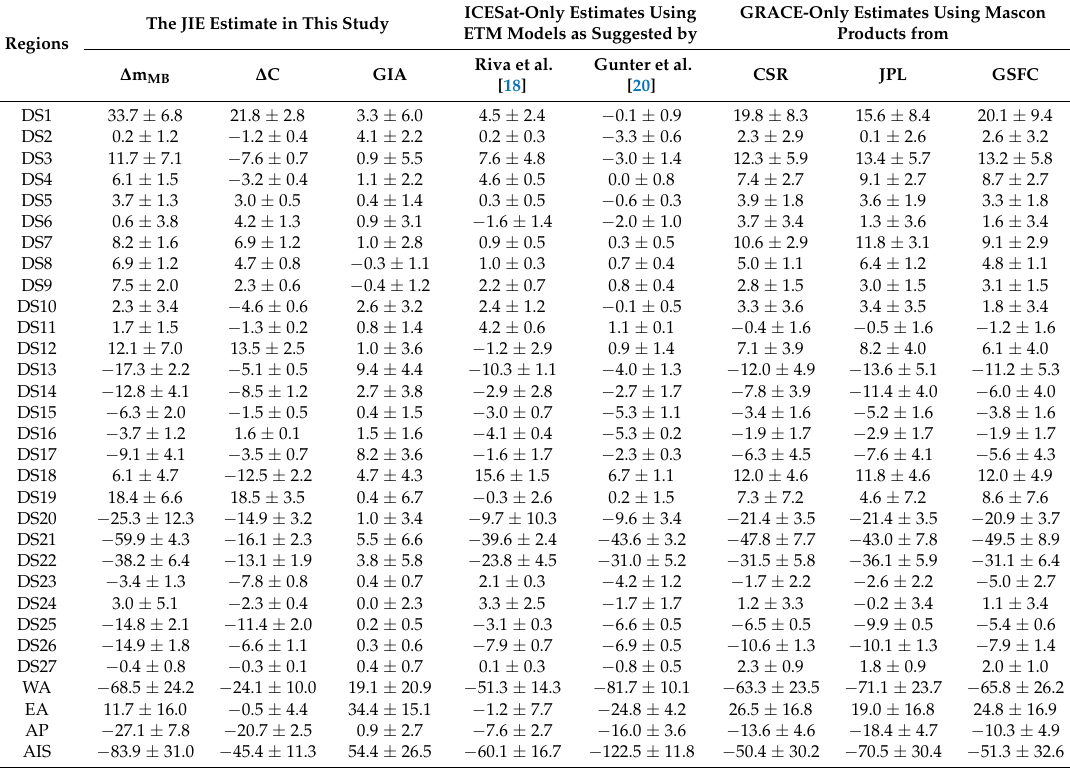
Table 5. The mean trends of 27 Antarctic drainage systems, the AP, WA, East Antarctica (EA), and the entire AIS for GIA-induced mass change and ice sheet mass balance derived from different methods over the period February 2003 to October 2009, in Gt/yr. The GIA effects for all ICESat-only and GRACE-only estimates are corrected using our GIA result. To reduce leakage-out errors across land/ocean boundaries, the regions of ice shelf are included in the Antarctic drainage systems when estimating from the Mascon solutions of Center for Space Research (CSR) and Goddard Space Flight Center (GSFC) (no need for the solution of Jet Propulsion Laboratory [JPL] due to that has been used a CRI